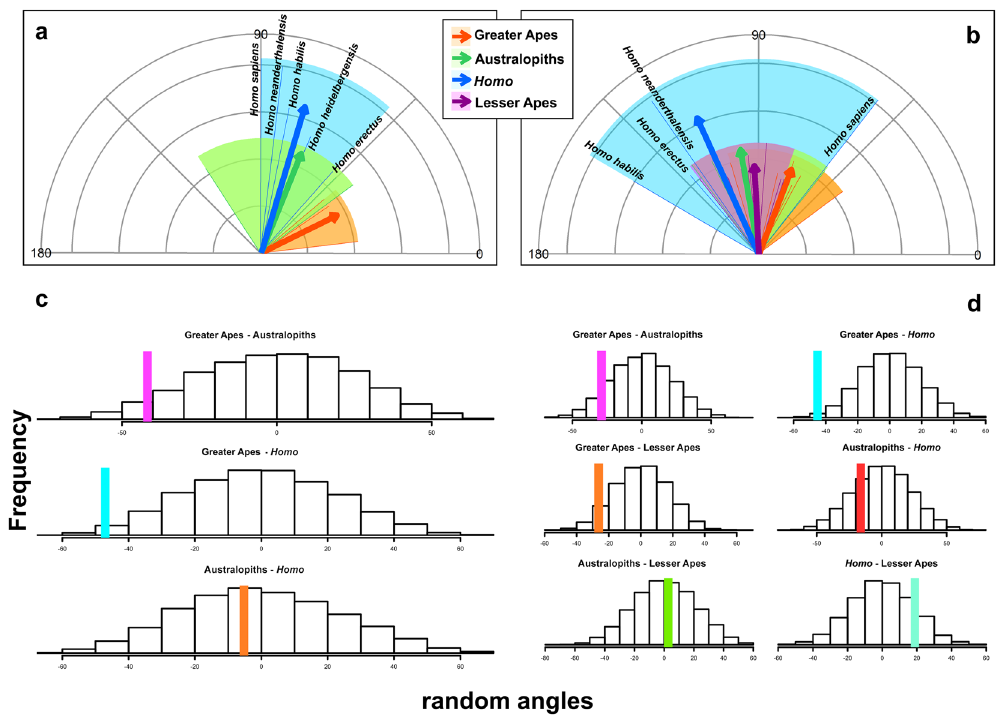
Figure 3. Multivariate angle comparisons among non-hominin apes, Homo species and the australopiths, assessed through multivariate angles between rate vectors. In ( a ) angles of Homo , australopiths, and non- hominin greater apes (Great Apes) are depicted starting from the common origin (the ancestor of all these species). The range of angles for each group is highlighted: Homo , transparent blue; Australopiths, transparent green; Great Apes, transparent orange. Vector length is proportional to actual vector size (i.e. the evolutionary rate). In ( b ) the same as with ( a ) but including lesser apes (Hylobatidae) highlighted in transparent purple. In ( c ) the angles in ( a ) are tested for significance by shuffling the rates among groups 10,000 times, real differences are indicated by the color bars. In ( d ) the angles in ( b ) are tested for significance by shuffling the rates among groups 10,000 times, real differences are indicated by color bars.